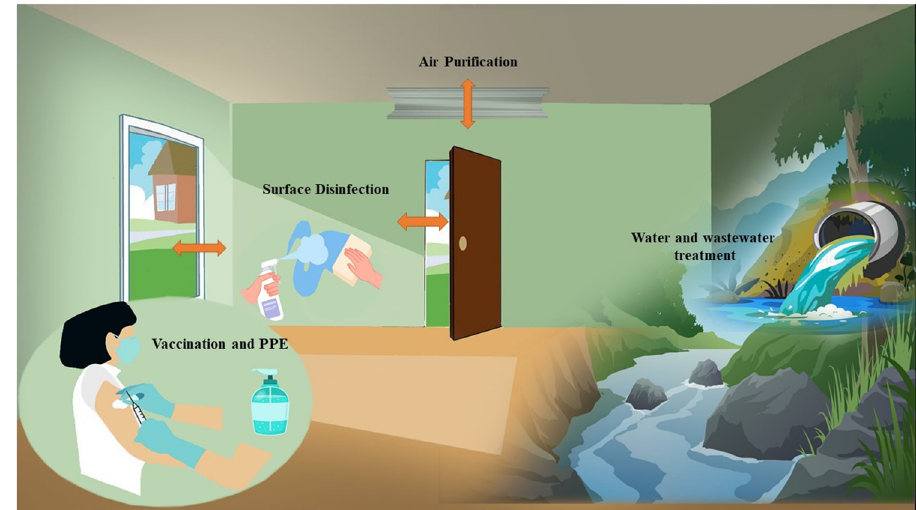
Figure 2: Schematic illustration for infection prevention against COVID -